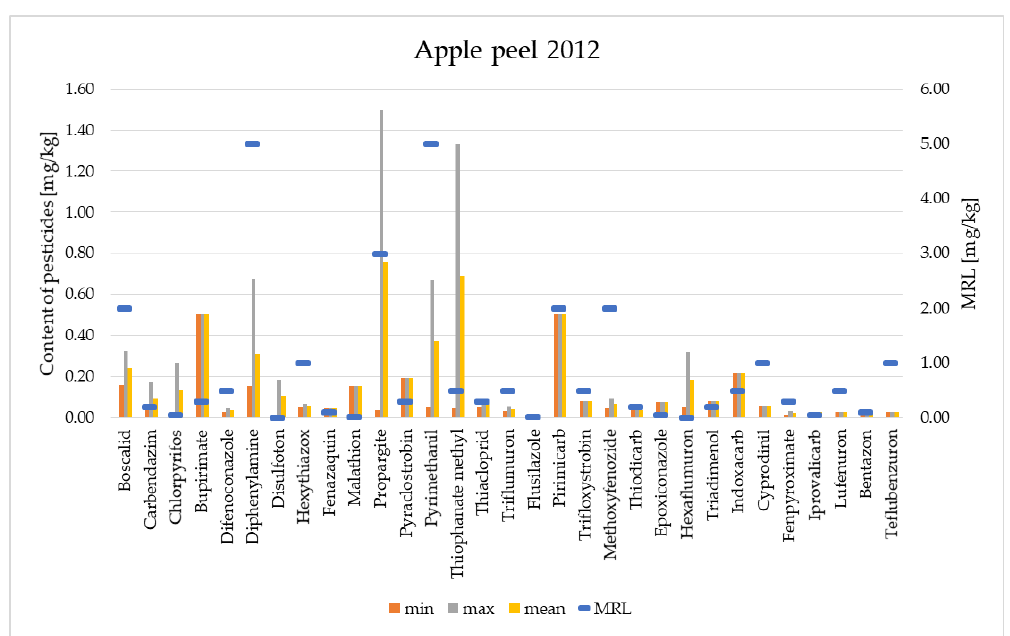
Figure 7. Content of pesticides in samples of peels of apples from the harvest of 2012.